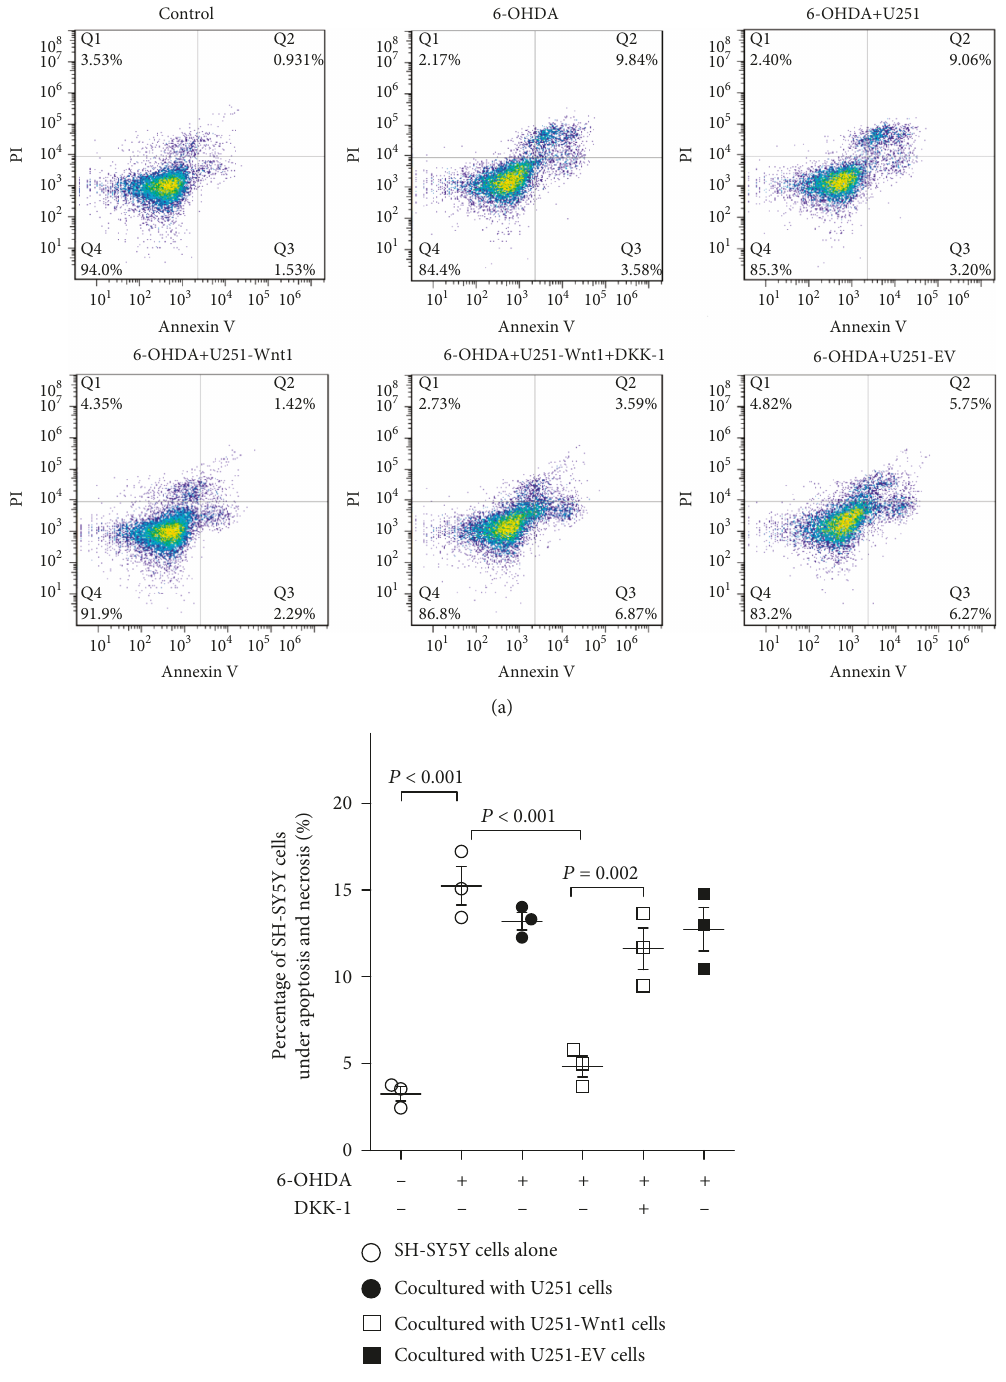
Figure 5: E ff ect of coculturing with U251-Wnt1 cells on 6-OHDA-induced damage in SH-SY5Y cells measured by fl ow cytometry. SH-SY5Y cells were indirectly cocultured with U251 cells, U251-Wnt1 cells, or U251-EV cells and then treated with or without 50 μ M 6-OHDA or 100ng/ml DKK-1 for 24h, and a combination of annexin V-FITC and PI staining was performed followed by fl ow cytometry. (a) Representative set of fl ow cytometric two-parameter dot plots in the corresponding groups. The lower right quadrant, which shows annexin V-FITC-positive and PI-negative cells, represents early apoptotic cells. The upper right quadrant, which shows both annexin V-FITC- and PI-positive cells, represents cells in the end stages of apoptosis and necrosis. (b) The percentage of cells under apoptosis and necrosis. Data are presented as the mean ± SD from 3 independent experiments. Di ff erences among groups were examined by using ANOVA followed by Tukey-Kramer tests for post hoc multiple comparisons. F value = 28.59, df = 12 , and df = 17 df withingroups total